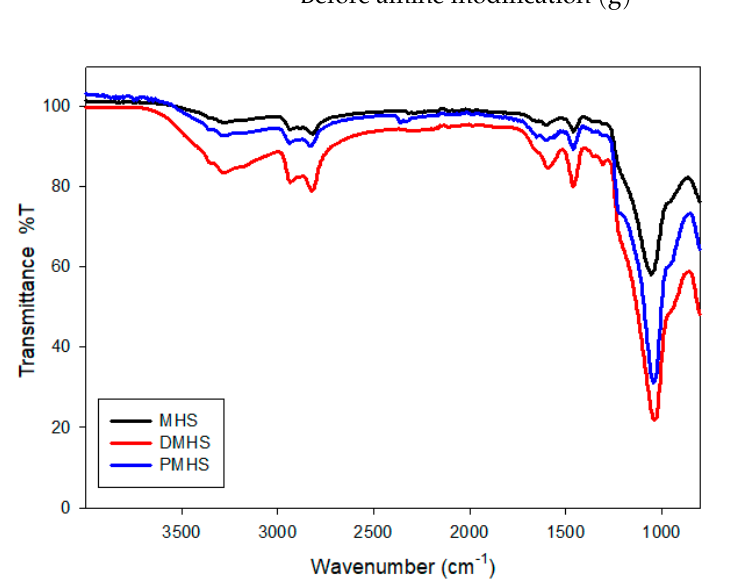
Figure 4. Infrared spectra of the MHS, PHMS, and DMHS after the amine modification. Table 2. EDS spectra of MHS, PHMS, and DMHS.